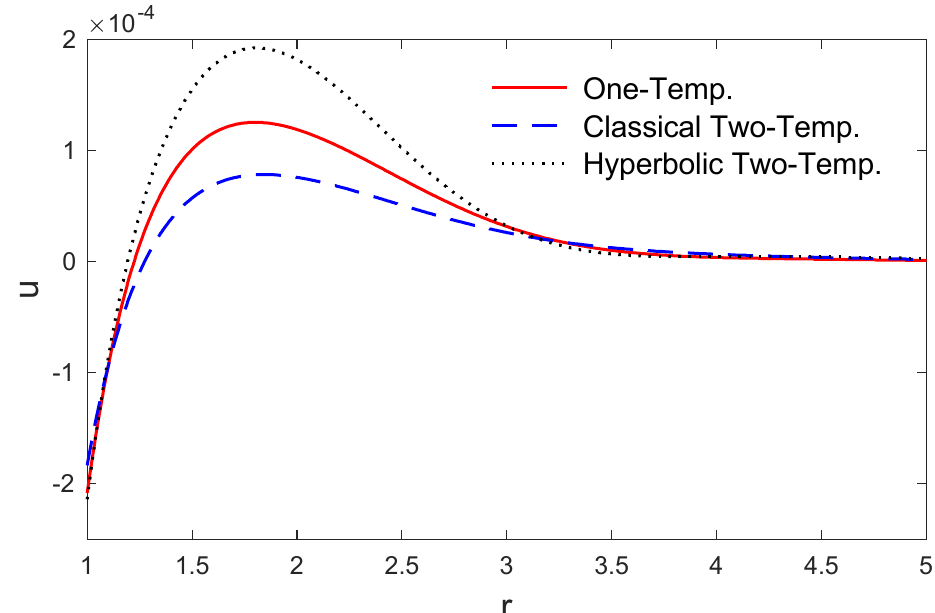
Figure 4. The variation of displacement with distance for different models.